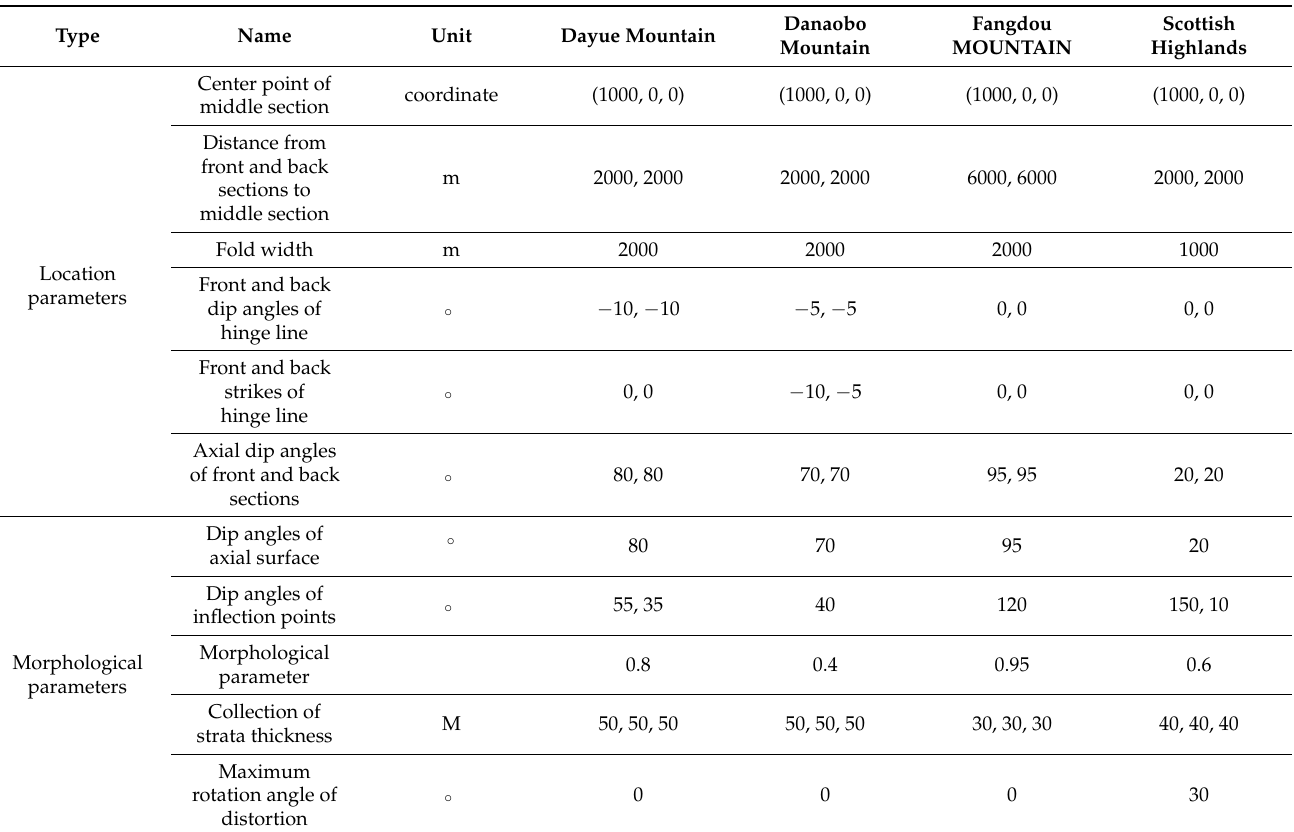
Table 5. Modeling parameters of each experimental